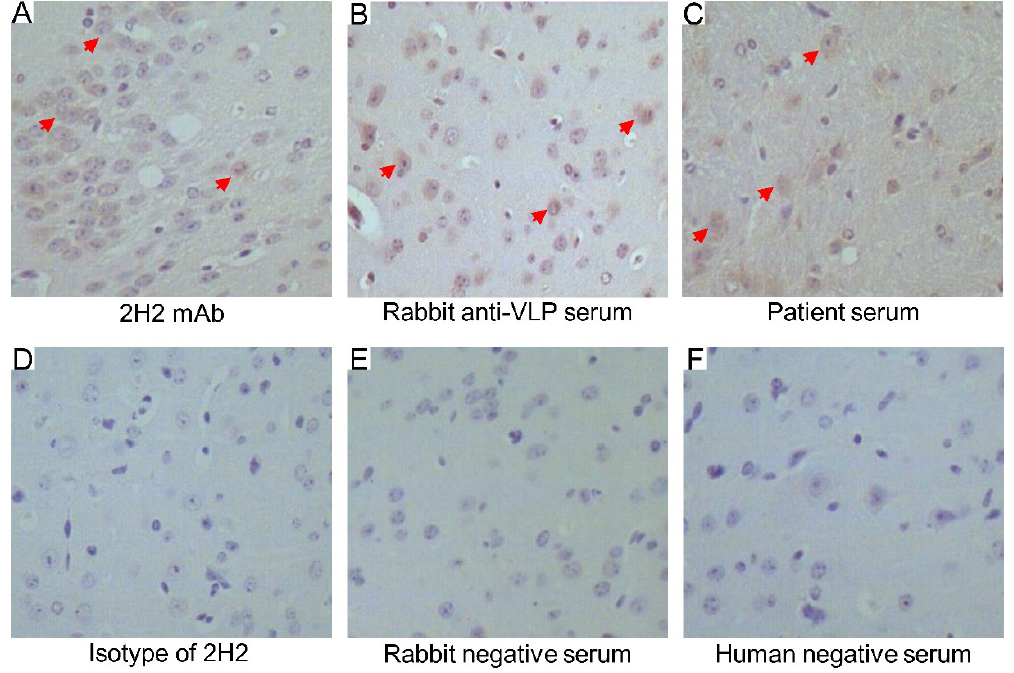
Figure 7. Cross-reactivity of 2H2, EV71 VLP-immunized rabbit serum and EV71-infected patient serum with mouse brain stem tissue. ( A ) The tissue slide was stained with 2H2 directly labeled with HRP, positive specific stains are indicated by red arrows; ( B ) tissue slides were stained indirectly with anti-VLP serum from rabbits, positive specific stains are indicated by red arrows; ( C ) tissue slides were stained indirectly with EV71-infected patient serum, positive specific stains are indicated by red arrows; ( D ) the HRP-labeled isotype-matched antibody was used as the negative control for 2H2 mAb; ( E ) the rabbit negative serum was used as the negative control for rabbit anti-VLP serum; and ( F ) the human negative serum from healthy human was used as the negative control for EV71-infected patient serum. Images were obtained at a magnification of